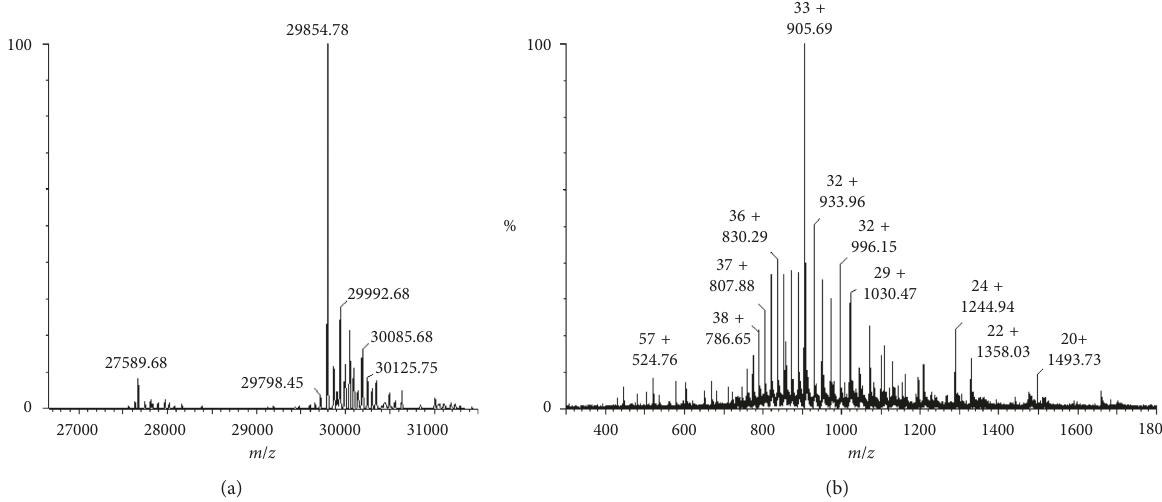
Figure 5: Mass spectrum intact. Differences of the intact mass spectrum analysis in deconvolved conditions (a) and in the spectrum showing the multicarga (b) ions of the thrombin-like protein TLBpic, which are observed in this spectrometry methodology, through electrospray mass (ESI).